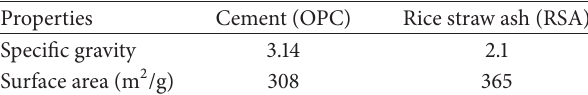
Table 1: Physical properties of OPC and RSA.